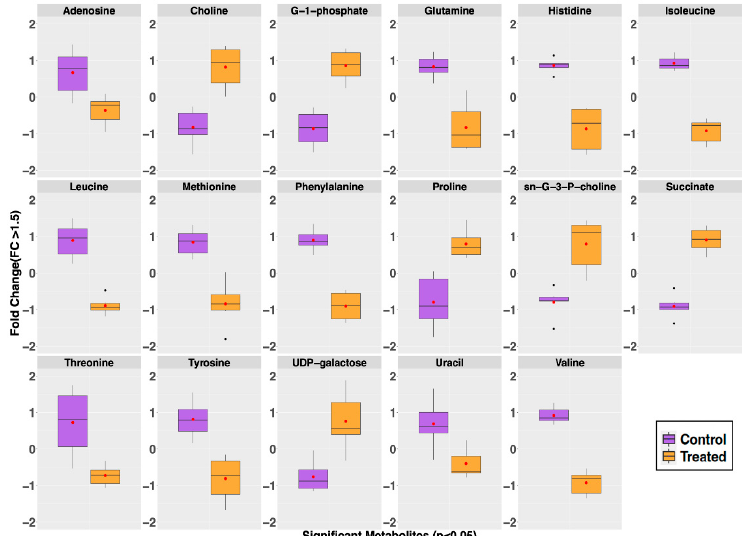
Figure 4. Intracellular metabolites whose level differences were significant (Fold change (FC) > 1.5 and p -value < 0.05) contributors for the separate classification of the GRA-treated (orange) from the untreated control (purple) groups. Whisker plots indicate ± 1.5* interquartile range (IQR) observations; values > 1.5 and <3 *IQR are represented as small black dots with the mean represented by a single red dot. Most notable is the observation of higher levels of choline, proline, succinate, sn-glycero-3-phosphocholine (sn-G-3-P-choline), and UDP-galactose in the GRA-treated group, while the levels of adenosine, glutamine, histidine, isoleucine, leucine, methionine, phenylalanine, threonine, tyrosine, valine, and uracil are all lower in the GRA-treated group compared to the control group.